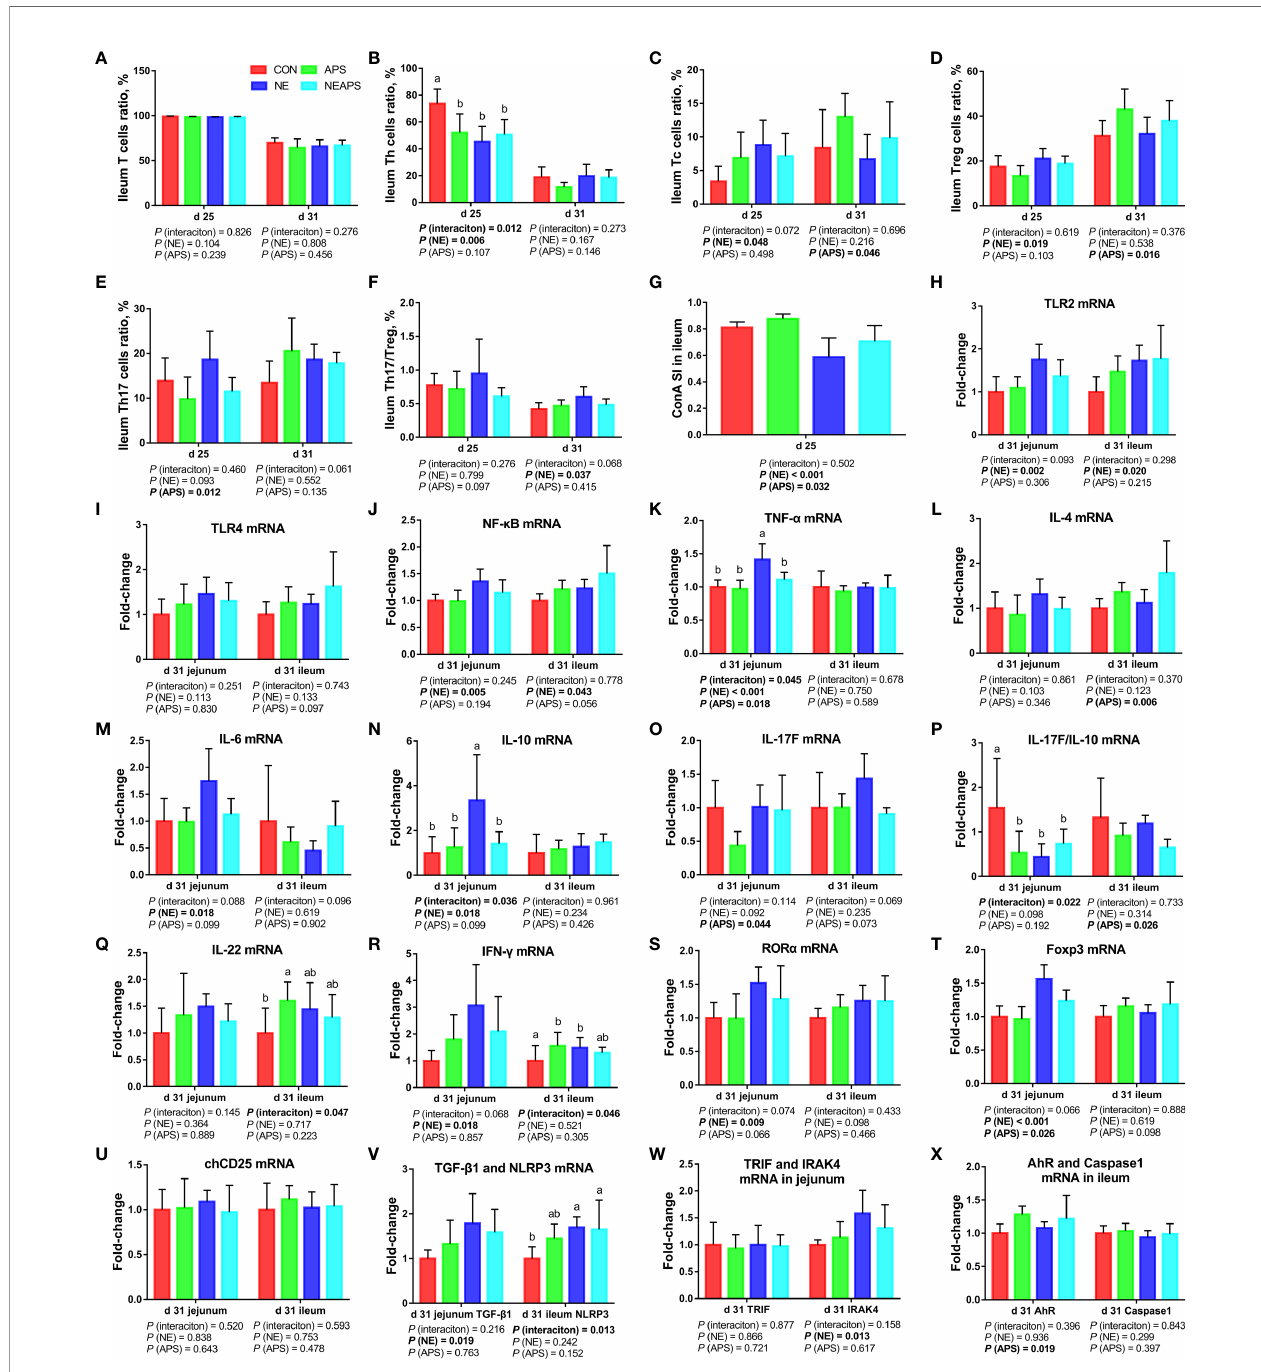
FIGURE 6 | Effects of dietary astragalus polysaccharides supplementation on intestinal cellular immune function of broiler chickens challenged with necrotic enteritis. The frequencies of T (A) , Th (B) , Tc (C) , Treg (D) and Th17 (E) of ileum lymphocytes were analyzed by fl ow cytometry. The Th17/Treg (F) of ileum lymphocytes was calculated by dividing the proportion of Th17 cells by the proportion of Treg cells. Ileum lymphocytes were stimulated with concanavalin A (ConA) (G) , and the stimulation index (SI) was calculated as described in the Materials and Methods section. The mRNA levels of TLR2 (H) , TLR4 (I) , NF- k B (J) , TNF- a (K) , IL-4 (L) , IL-6 (M) , IL-10 (N) , IL-17F (O) , IL-17F/IL-10 (P) , IL-22 (Q) , IFN- g (R) , ROR a (S) , Foxp3 (T) , chCD25 (U) , TGF- b 1 (V) , NLRP3 (V) , TRIF (W) , IRAK4 (W) , AhR (X) and Caspase1 (X) in jejunum and ileum were analyzed by RT-PCR. All graphs are presented as mean, with the standard deviation (SD) shown via the whiskers. The main effect and interaction effects were analyzed using the general linear model (GLM) procedure, with the P values for the main effects written out below each plot. The one-way ANOVA and multiple comparisons were performed when interactive effects differed signi fi cantly. The lowercase letters on the bar charts indicate signi fi cant differences ( P < 0.05). CON, control group; APS, APS group; NE, NE infection group; NEAPS, APS infected with NE